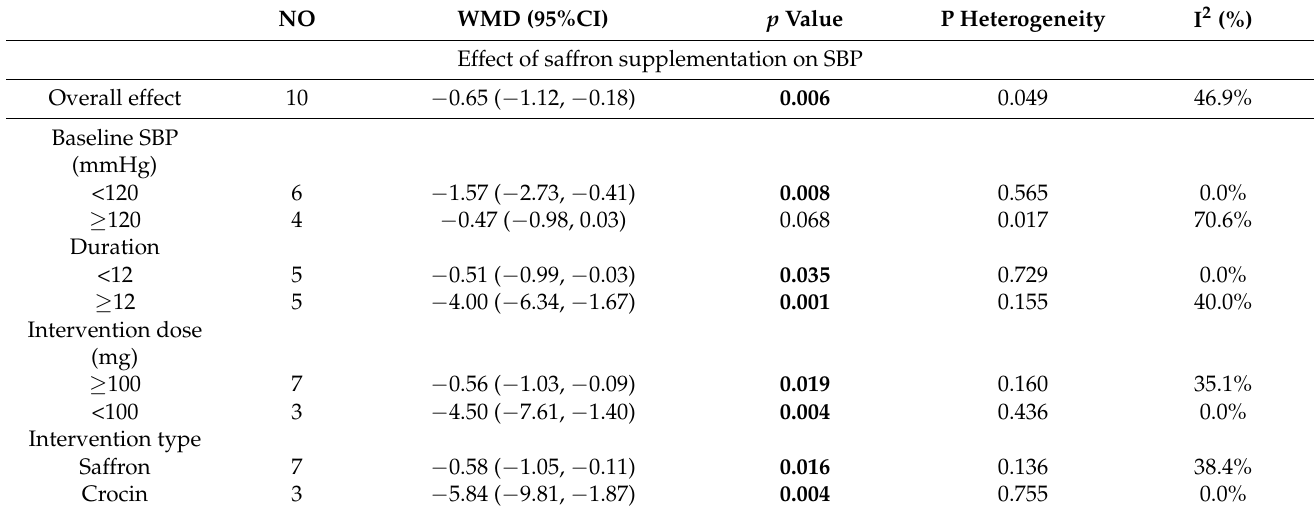
Figure 2. The effects of saffron supplementation on SBP. Table 2. The effects of saffron supplementation on blood